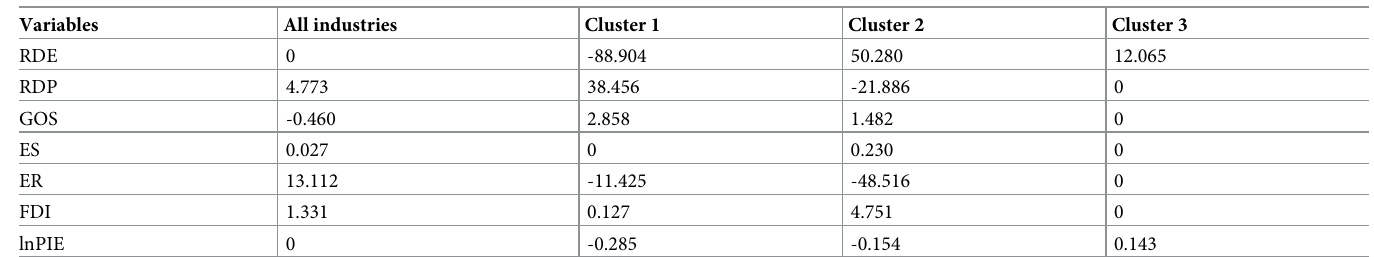
Table 6. Lasso regression coefficient of industries in different cluster. Variables